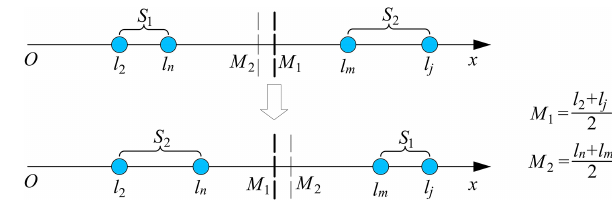
Figure 3. Schematic diagram of the linkage repairing technique.